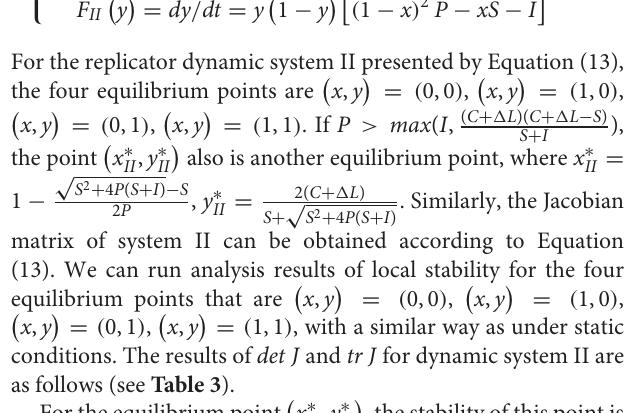
S ). (A) Arbitrary proportion. (B) Specific 1 L + −